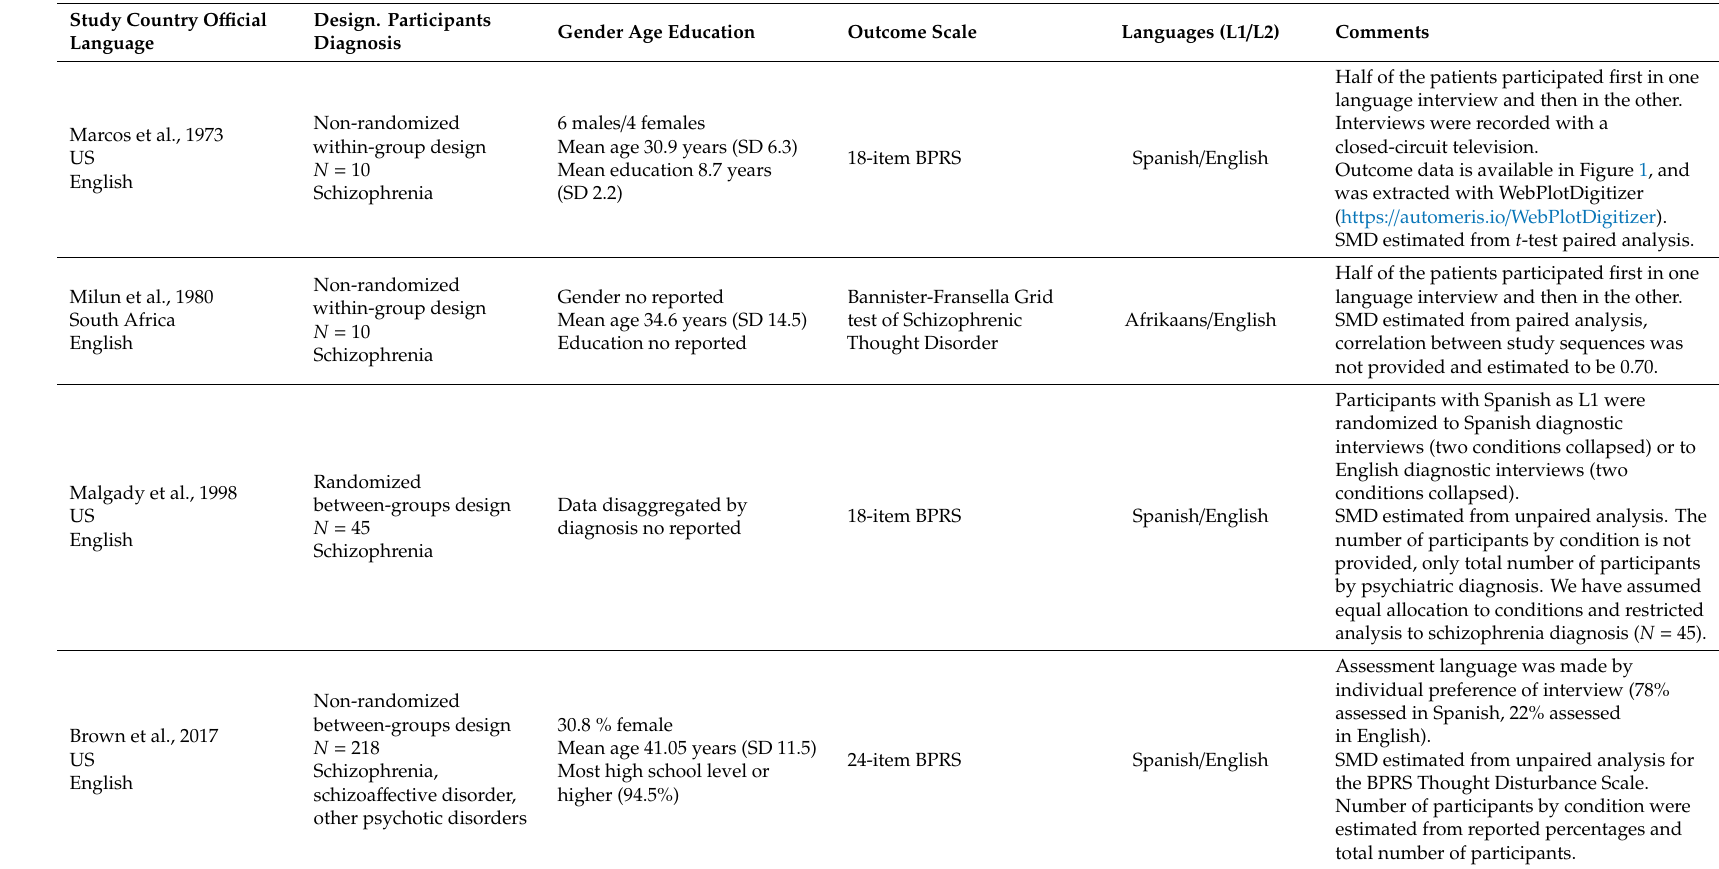
Table 1. Characteristics of included